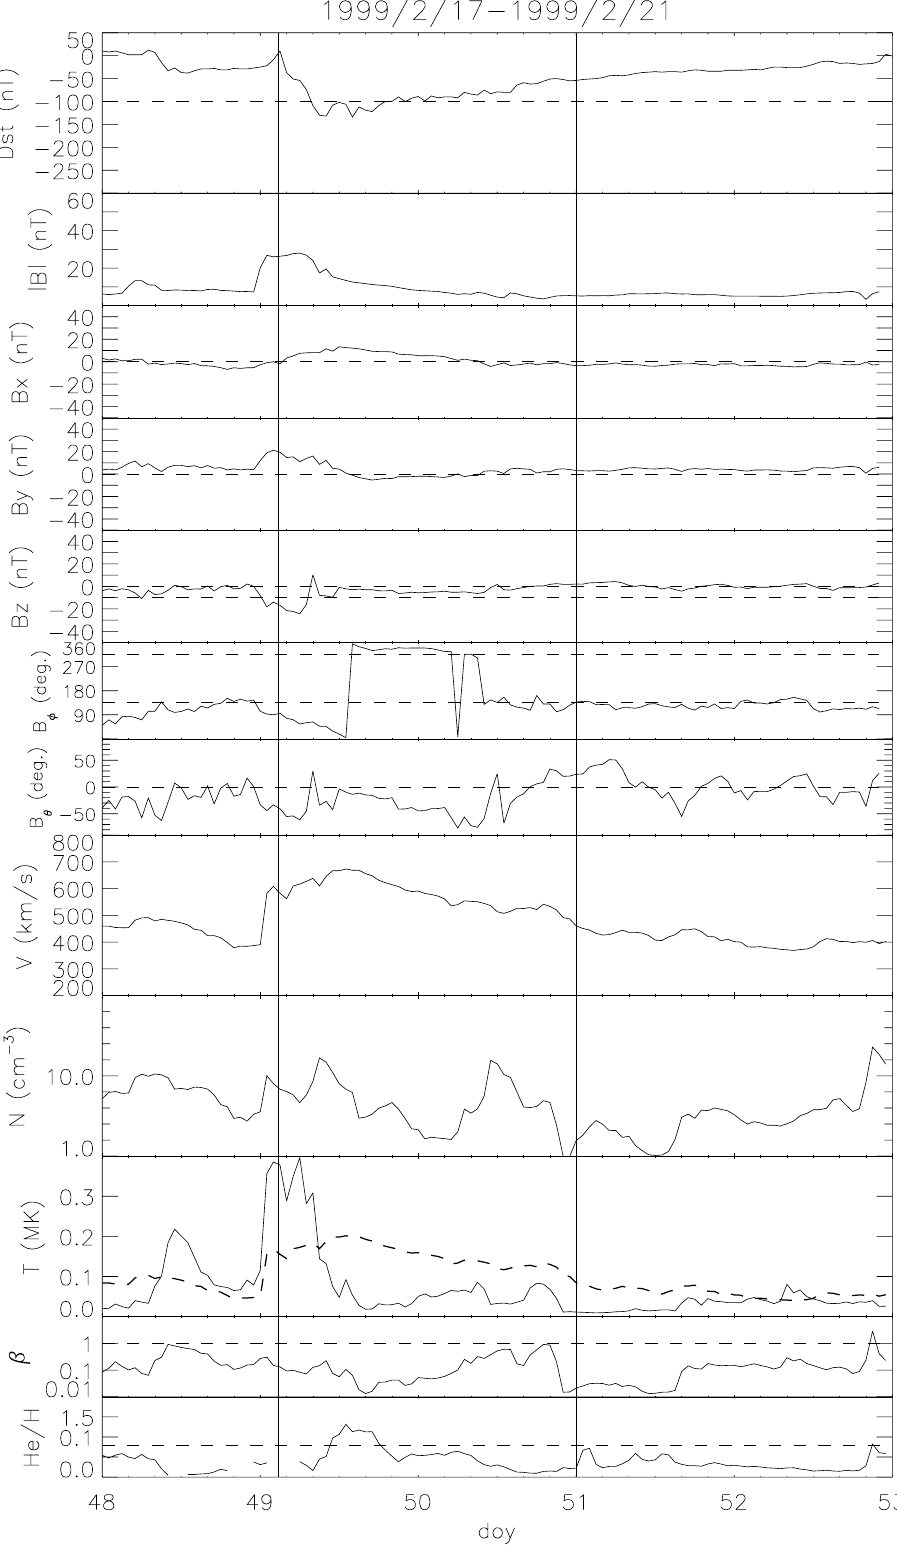
Fig. 9. D st index and solar wind parameters of storm no. 13. Two vertical solid lines show the duration of the geomagnetic